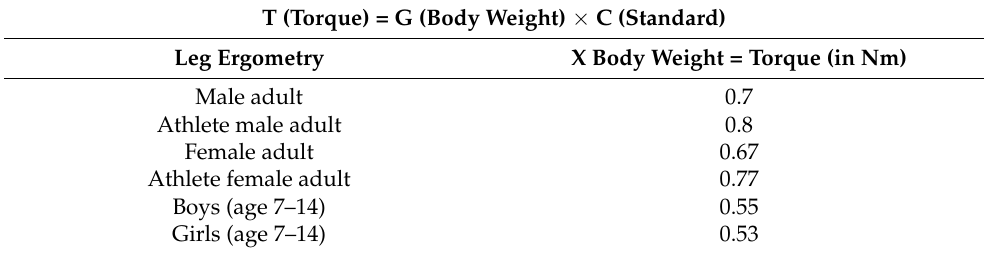
Table 2. Cyclo-ergometer resistances suitable for WAT. Table obtained from